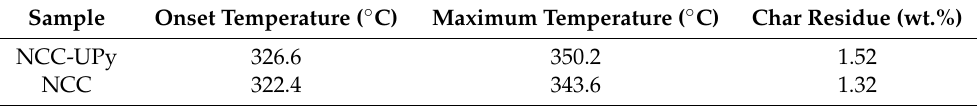
Figure 9. ( a ) TG and ( b ) DTG curves of NCC and NCC-UPy. Table 2. Analysis results from TG and DTG